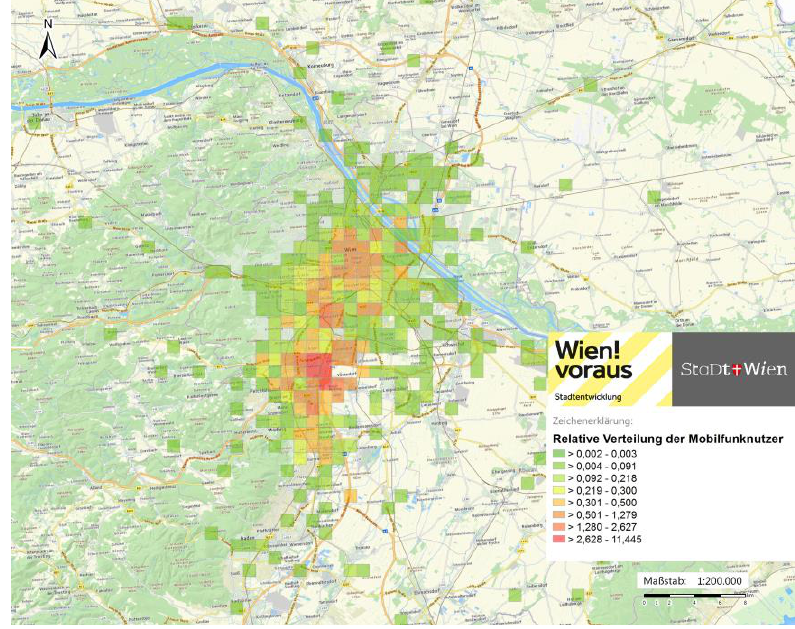
Figure 13. Mobility pattern of suburban residents living in the south of Vienna (German labels are used to support local language).